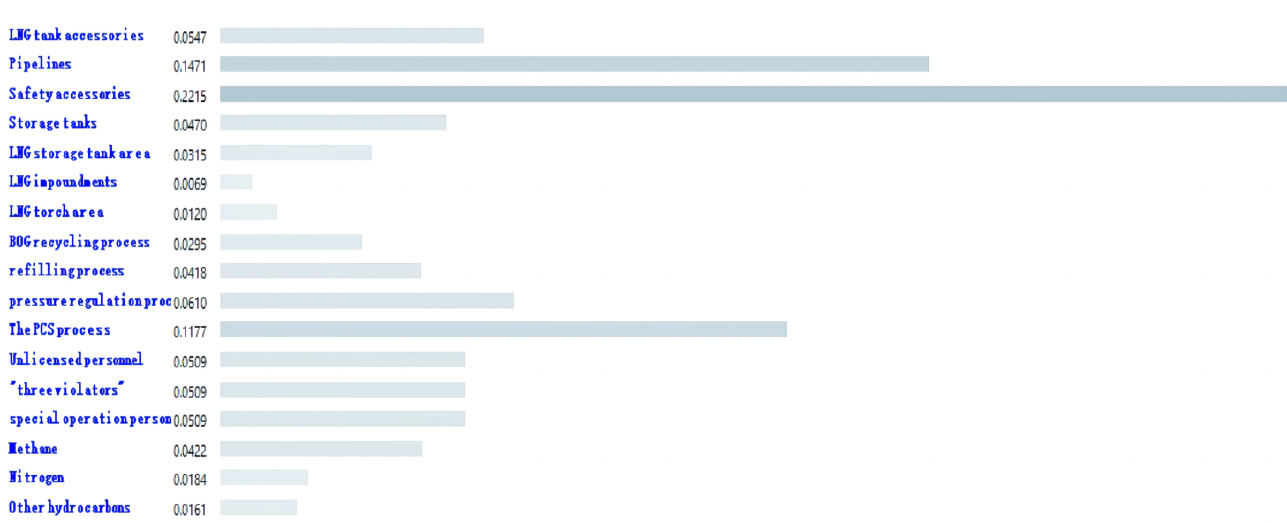
Figure 8. Secondary index weights in AHP.